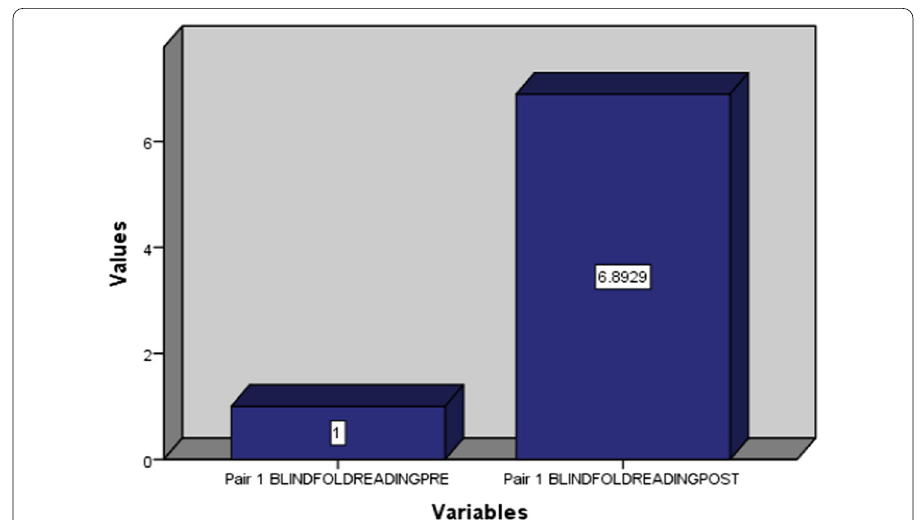
Fig. 8 Paired samples statistics: blindfold reading/colour identification. Source: SPSS 23.0 output